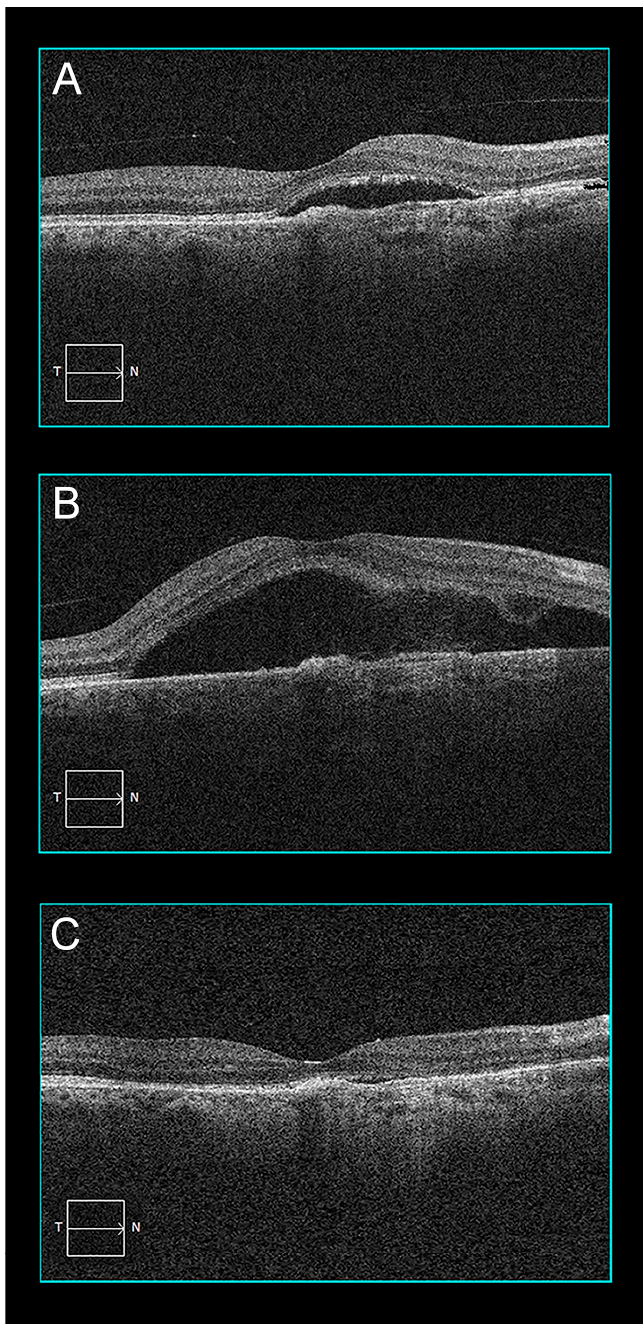
Figure 2. Patient 1 optical coherence tomography evolution before and after PDT: ( A ) Baseline OCT B-scan showing subretinal fluid and a shallow retinal pigment epithelium detachment; ( B ) two days after PDT, there was increased exudation with a bacillary layer detachment; ( C ) after 2 months, exudation resorption was almost